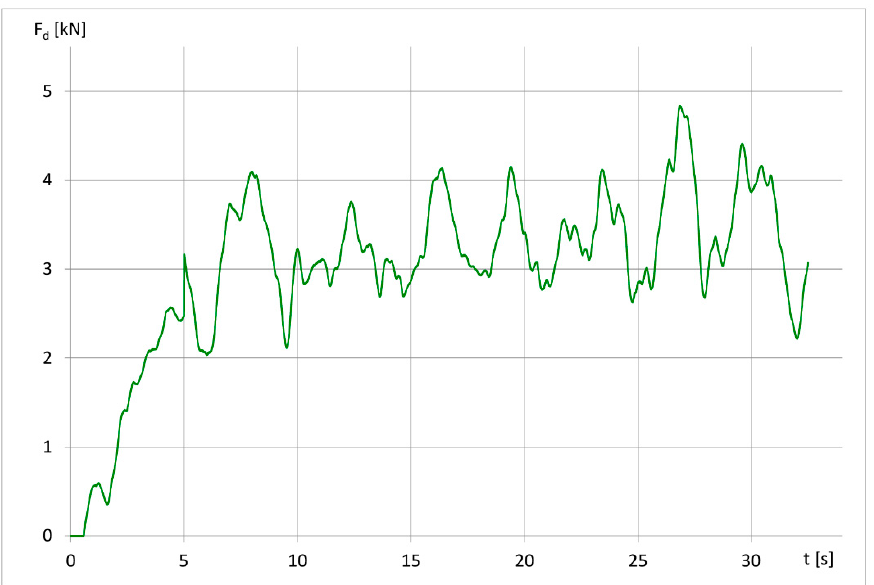
Figure 7. Changes in time of the measured drawbar pull of the tractor F d with enabled force control system; soil profile—silty loam, first gear.